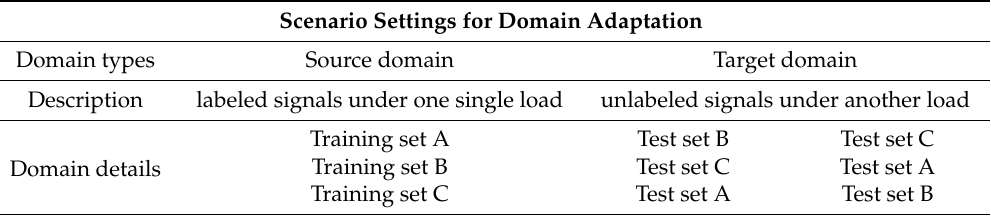
Table 3. Description of scenario settings for domain adaptation.